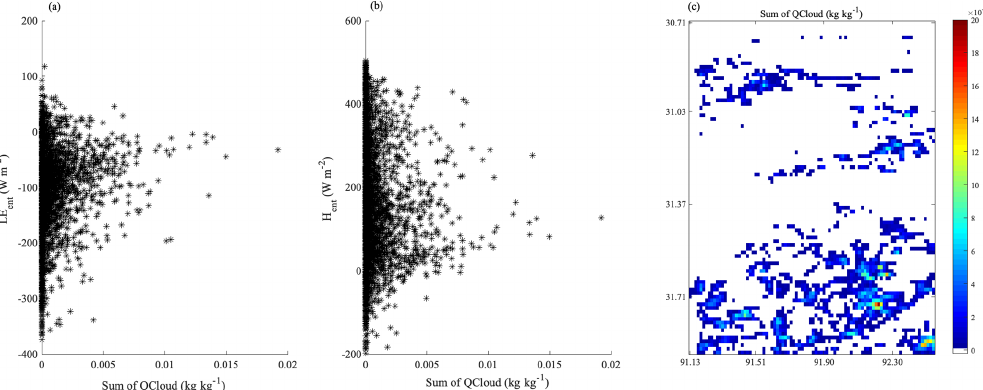
Figure 9. (a) Relationship between LE ent and the sum of Q Cloud . (b) Relationship between H ent and Q Cloud . Simulated using WRF with Noah-BouLac. (c) Spatial distribution of the sum of Q Cloud .